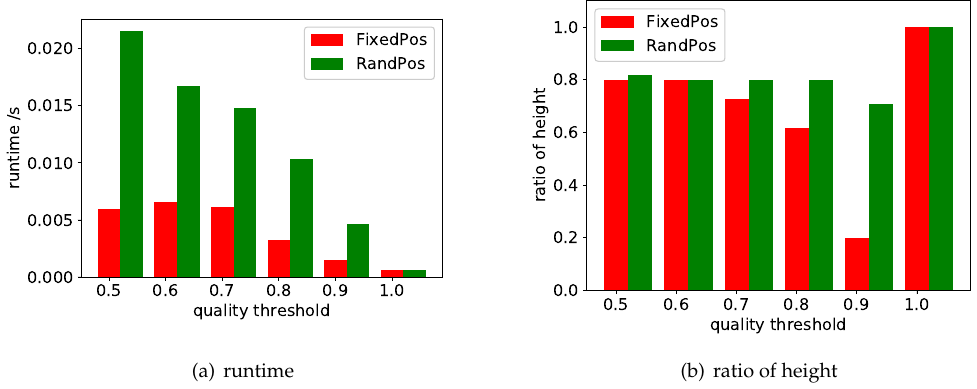
Figure 7. Experimental results of search space size